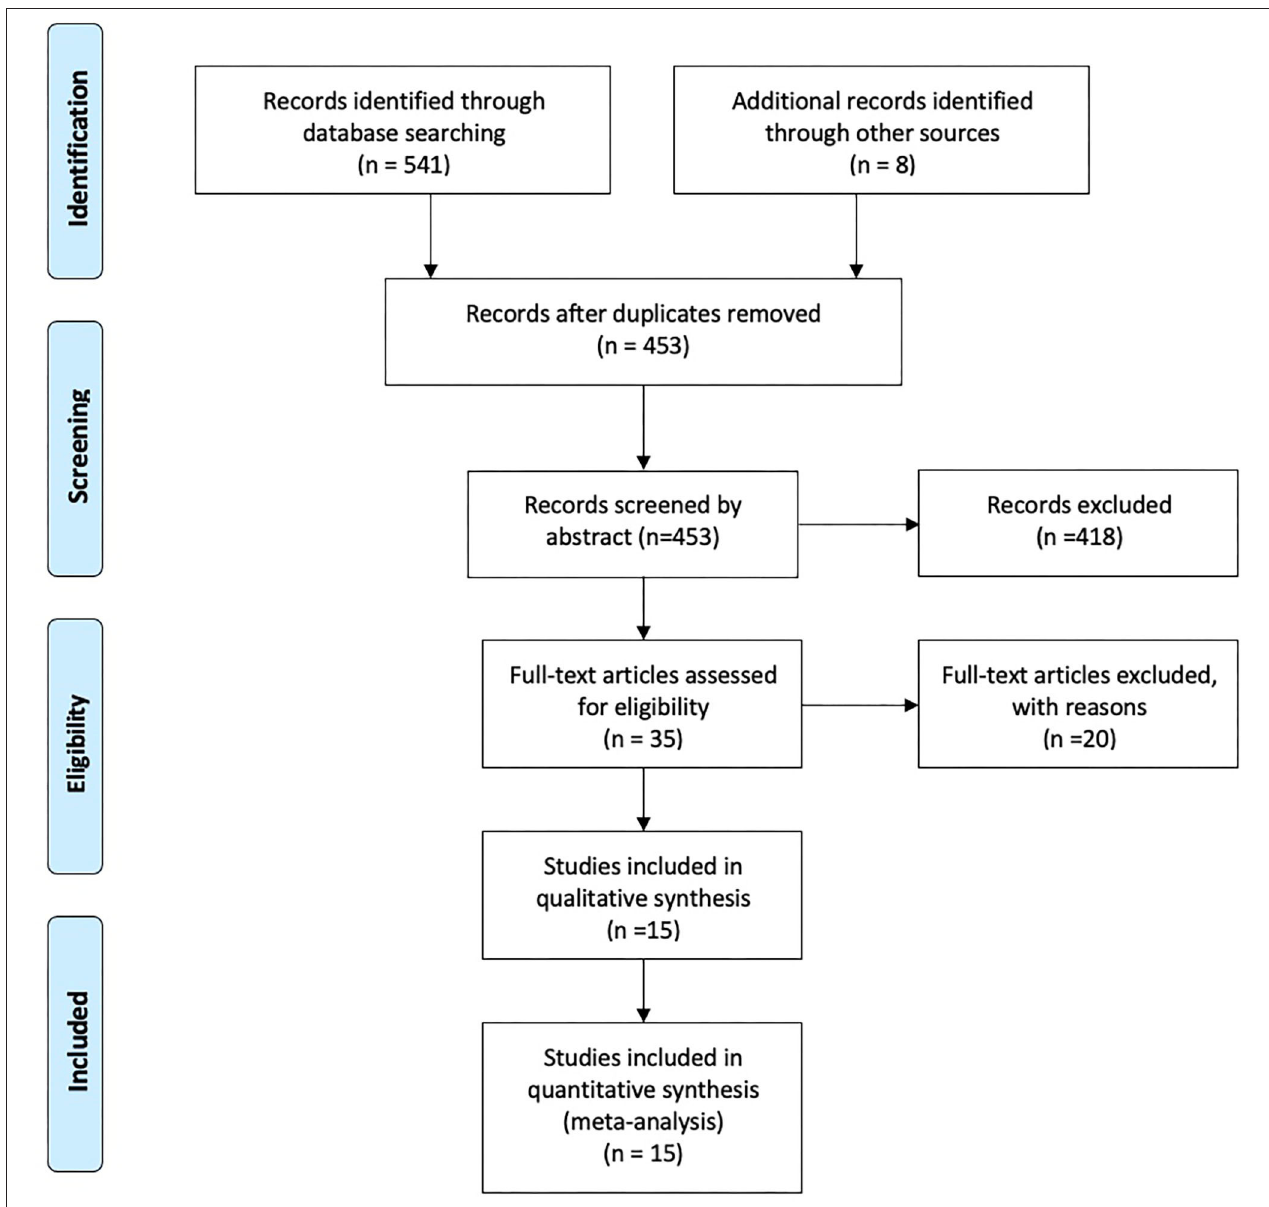
FIGURE 1 | Flow chart. Physician–patient language discordance and poor health outcomes: A systematic review, Spain–UK,